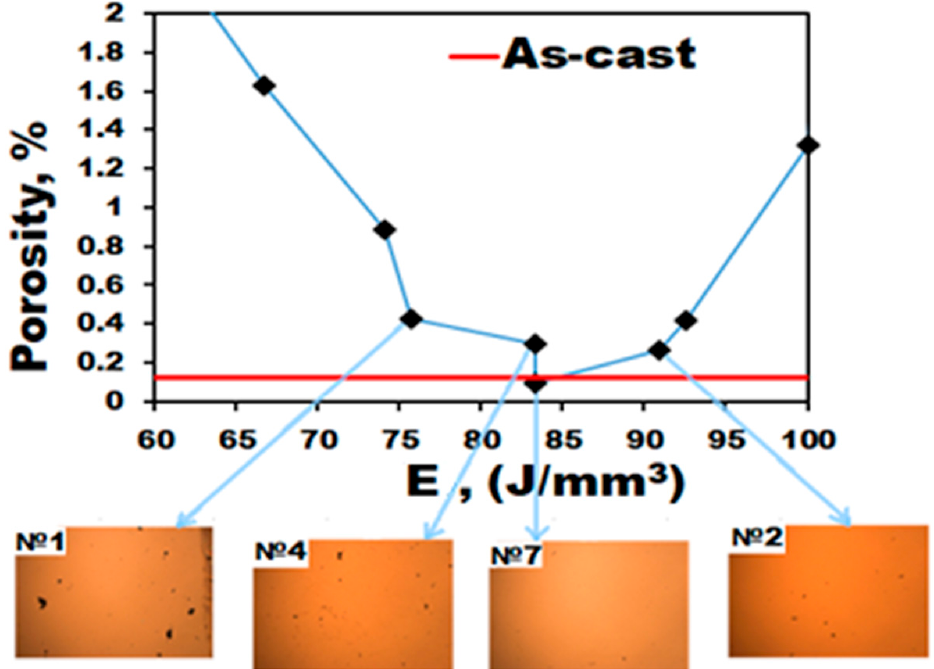
Figure 4. Dependence of the pore volume fraction on the energy density ( E ) and OM images of some representative specimens.